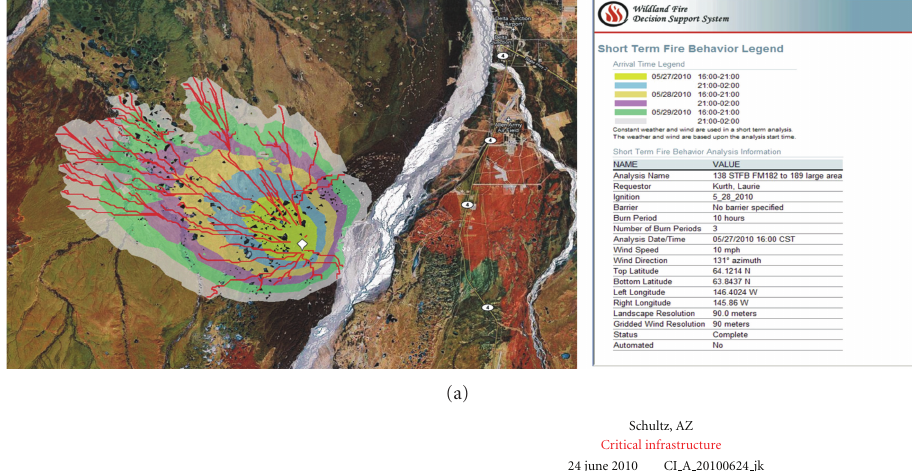
overlaid with values at risk. This is referred to as a rapid assessment of values at risk (RAVAR, see Section